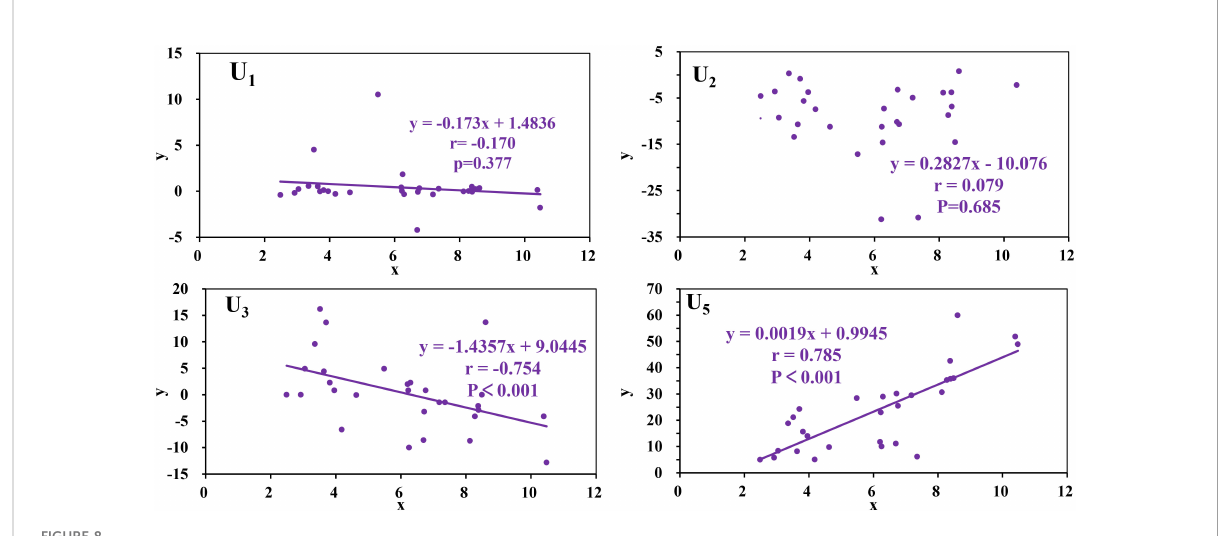
FIGURE 8 Correlation diagram of comprehensive evaluation vulnerability results and single factor index Ui linear regression (x in the fi gure is the comprehensive evaluation erosion vulnerability index, y is the original data of the factor